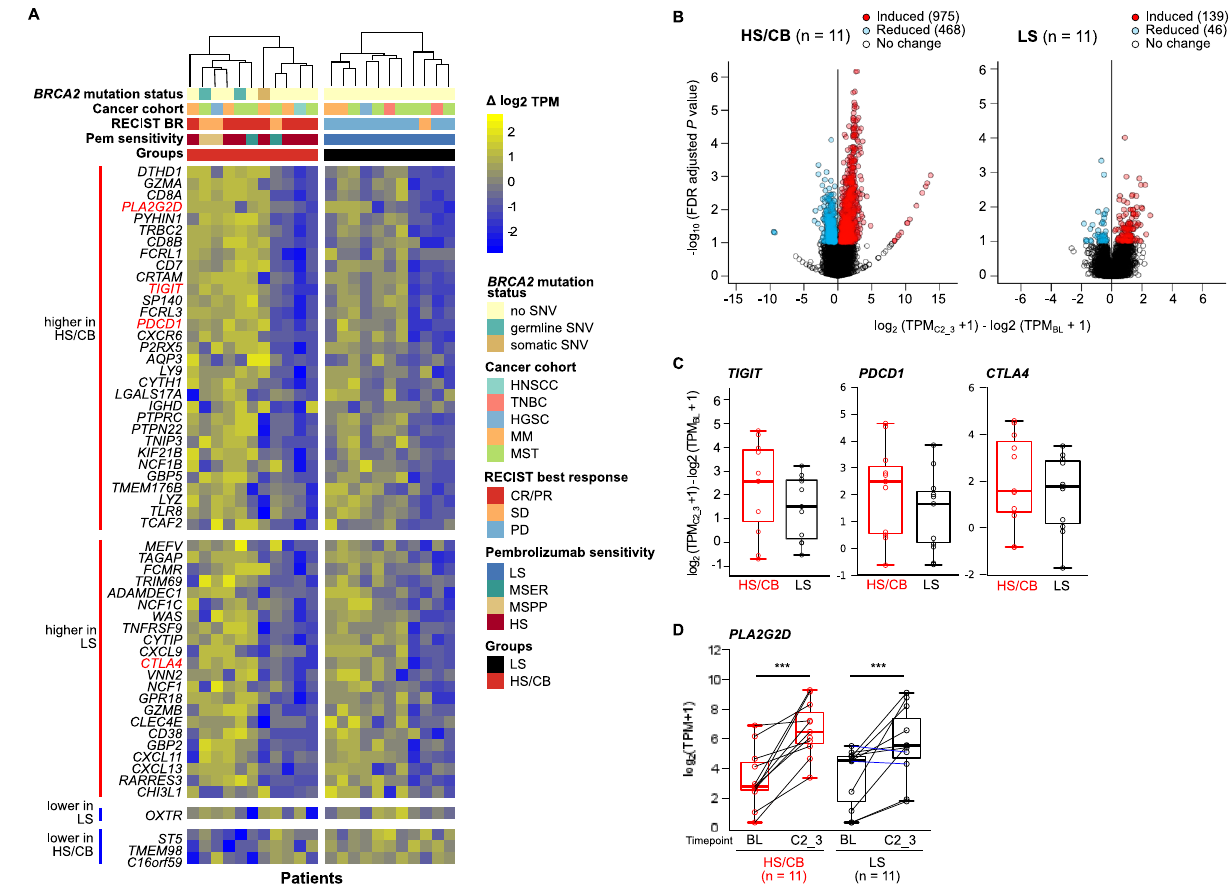
Fig. 4 Genes differentially regulated by pembrolizumab treatment in treatment sensitive and resistant tumors. A Heatmap of differentially regulated genes by pembrolizumab treatment to differentiate treatment sensitive from insensitive tumors. Samples are grouped by HS/CB or LS and sorted by hierarchical clustering within each group based on the similarity of change in gene-expression of selected genes. Genes are organized into four groups according to the combination of gene-regulation and differences between the two comparison groups. From top to bottom: genes up-regulated in both groups with higher expression in the HS/CB group, genes up-regulated in both groups with higher expression in the LS group, genes down-regulated in both groups with a greater degree of down-regulation in LS, and genes down-regulated in both groups with a greater degree of down-regulation in HS/CB. Genes in each group are listed in decreasing order of the difference of median change in gene-expression between HS/CB and LS groups. B Volcano plots of differentially expressed genes comparing paired early on-treatment to baseline tumor gene-expression in HS/CB or LS groups. Statistical signi fi cance for gene selection: FDR-adjusted p -value ≤ 0.10. C Distributions of change in gene-expression of immune checkpoint genes ( TIGIT , PDCD1 , CTLA4 ) in HS/CB ( n = 11) versus LS ( n = 11) baseline and on-treatment tumor pairs. The median for each group is marked by a horizontal line in the center of a rectangle and data points are shown as open circles. The distance between the third-quartile (Q3) and fi rst-quartile (Q1), known as the interquartile range (IQR), is marked around the median by a rectangle. Vertical lines extending from the top and bottom of the rectangle show the maximum (Q3 + 1.5-times IQR) and minimum (Q1 + 1.5-times IQR). D PLA2G2D gene expression before and after pembrolizumab treatment in HS/CB ( n = 11, p = 0.001) or LS ( n = 11, p = 0.005) tumors before and after 2 – 3 cycles of pembrolizumab treatment. P -values were calculated by two-sided Wilcoxon rank-sum tests and uncorrected for multiple testing. The median for each group is marked by a horizontal line in the center of a rectangle and data points are shown as open circles. The distance between the third-quartile (Q3) and fi rst-quartile (Q1), known as the interquartile range (IQR), is marked around the median by a rectangle. Vertical lines extending from the top and bottom of the rectangle show the maximum (Q3 + 1.5-times IQR) and minimum(Q1 + 1.5-times IQR). Source data are provided in SourceData_Fig4.zip. LS low sensitivity, HS/CB high-sensitivity/clinical bene fi t, FDR false discovery PDL1 had higher PLA2G2D expression in pre-therapy tumors compared to non-responders in urothelial cancer 30 and anti- CTLA4 pre-treated advanced melanoma 20 data sets ( p < 0.10, uncorrected for multiple testing, Supplementary Fig. 11) 31 .